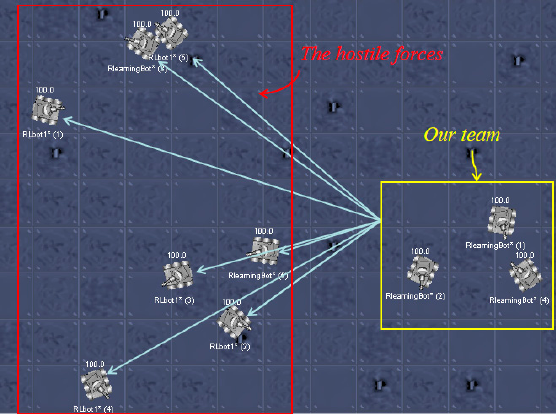
Figure 15. Simulation experiments for the TF method.